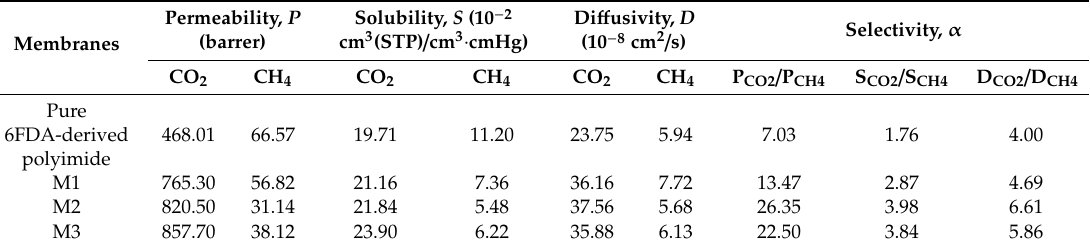
Intramolecular bond